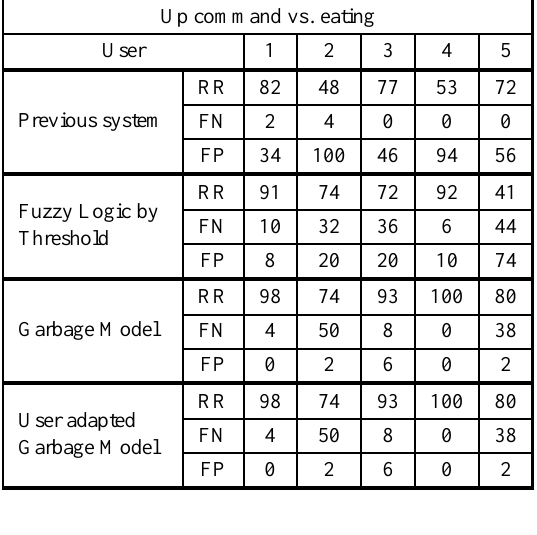
Table 6. Experimental results for ‘up’ command Up command vs.